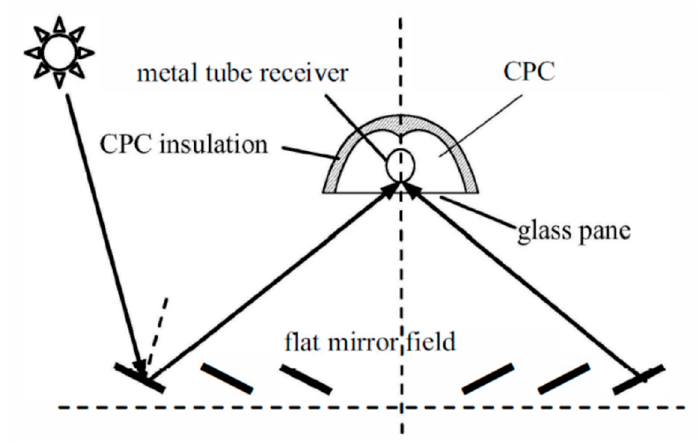
Figure 31. Cross-sectional view of Fresnel solar collector with CPC [64].